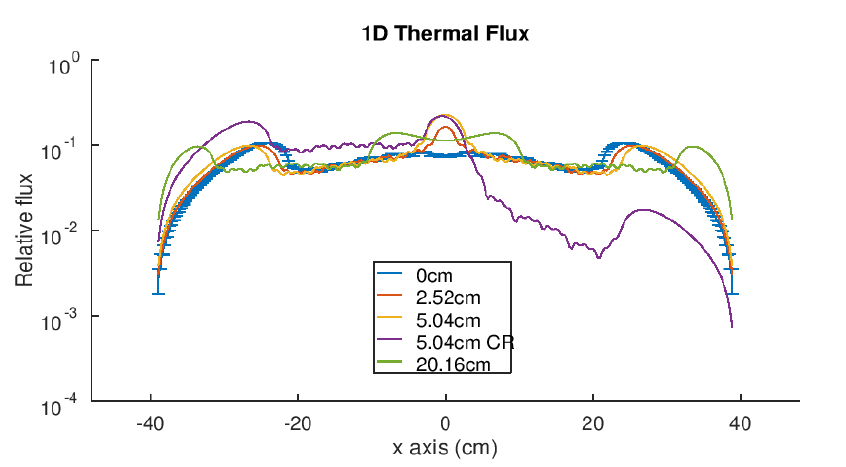
Figure 6. 1D thermal flux, including the result of control rod insertion (5.04cm